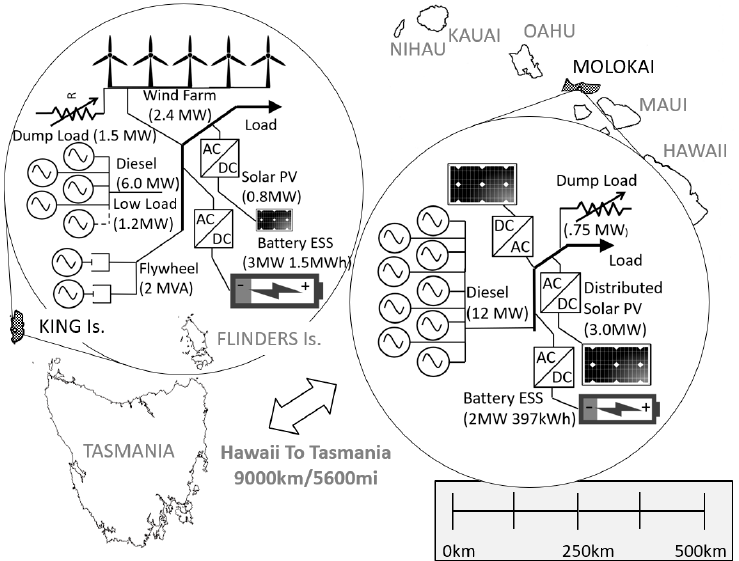
Figure 1. King Island isolated power system schematic, left hashed, and Moloka‘i isolated power system schematic, right hashed.